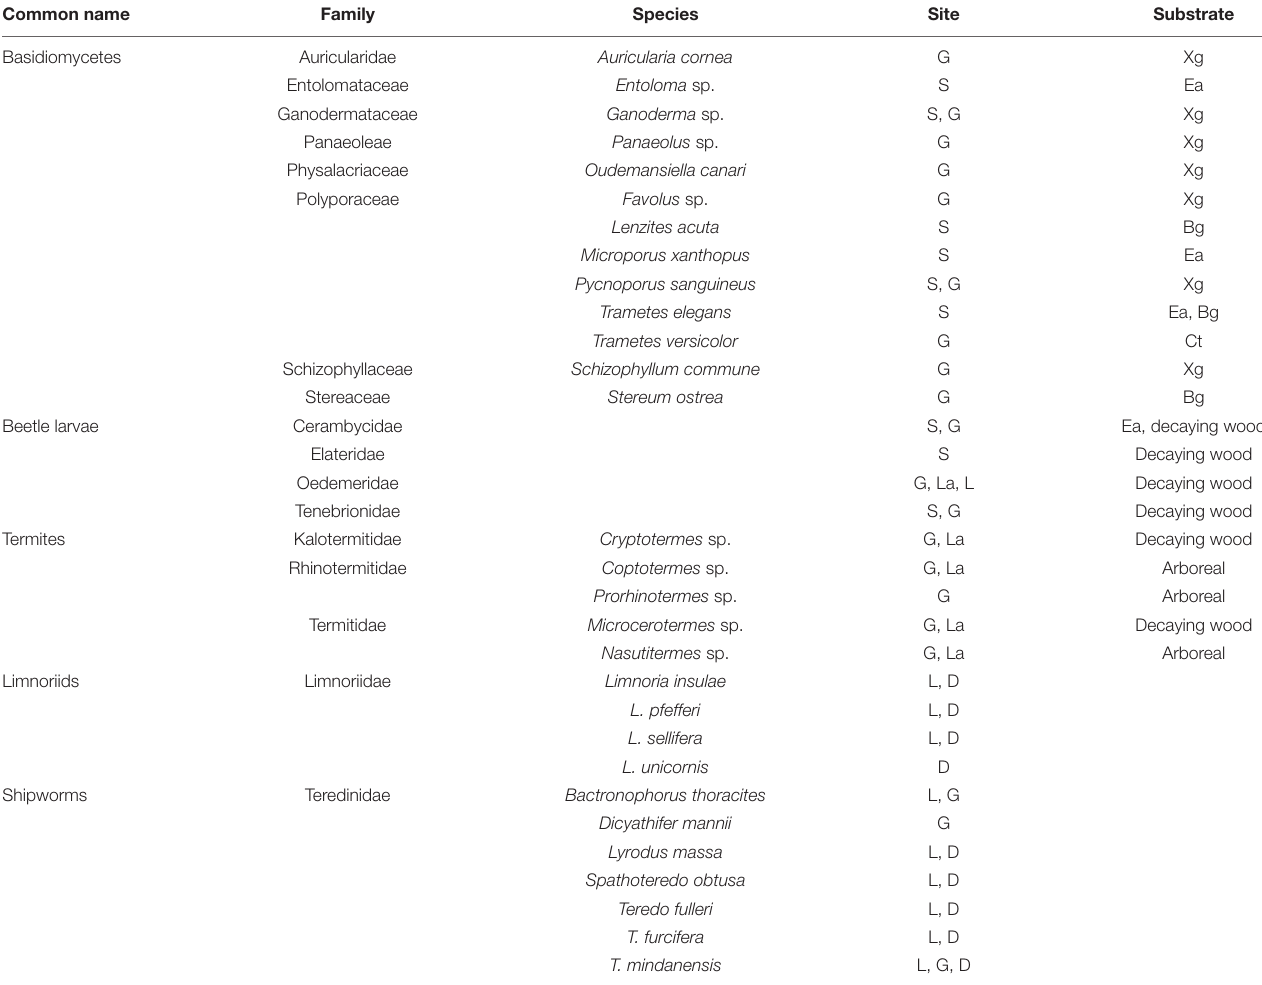
TABLE 2 | Wood degrading organisms recorded within mangrove forests of Kaledupa Island,